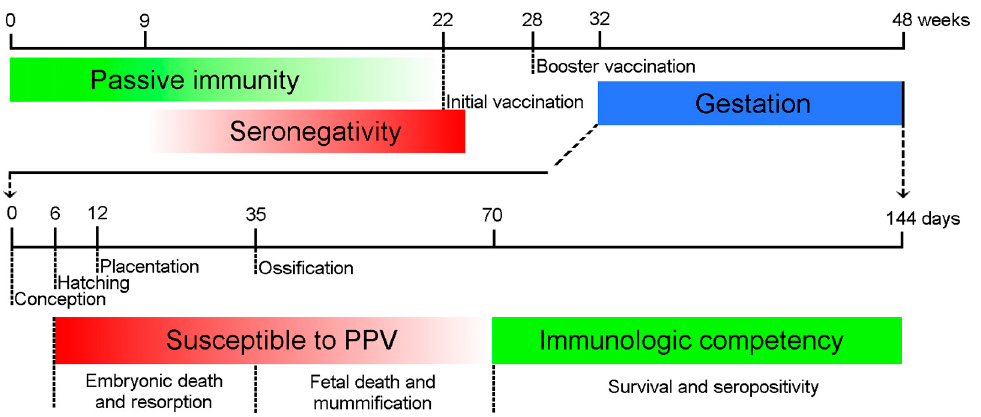
Figure 1. Major time points of Porcine Parvovirus (PPV) infection and immune response. The maternal antibodies protect the piglets passively (green line) until 9–22 weeks of age. The animals should be inoculated first after the depletion of maternal antibodies, and long-term immunity is maintained by booster vaccination. The embryos are susceptible to the infection (red line) until the Development of immune competence around day 70 day of gestation (green line). The consequences of the intrauterine infection depend on the time of the infection.